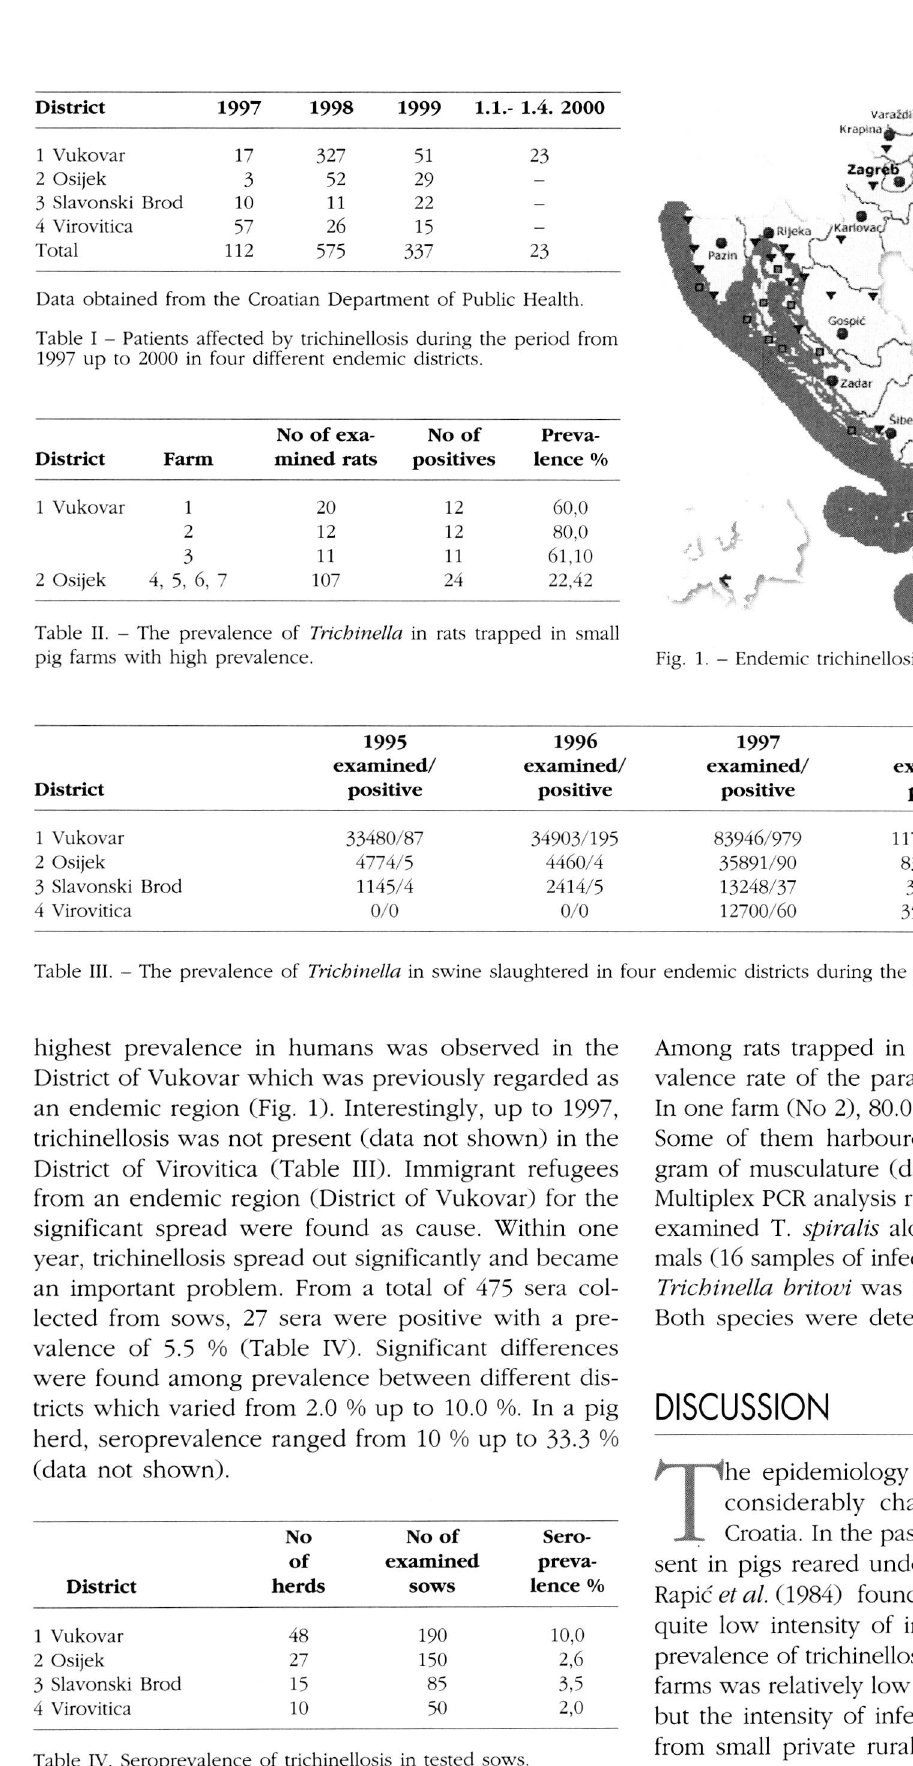
Table IV. Seroprevalence of trichinellosis in tested sows.